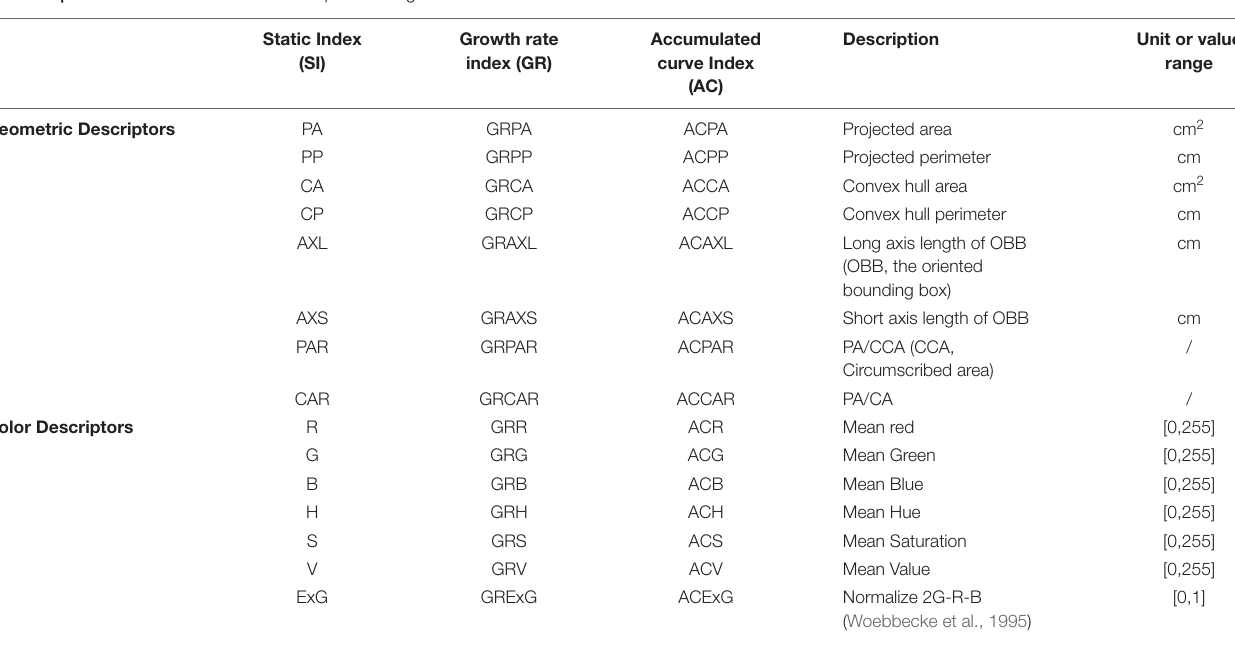
TABLE 1 | Lettuce features extracted from top-view images.